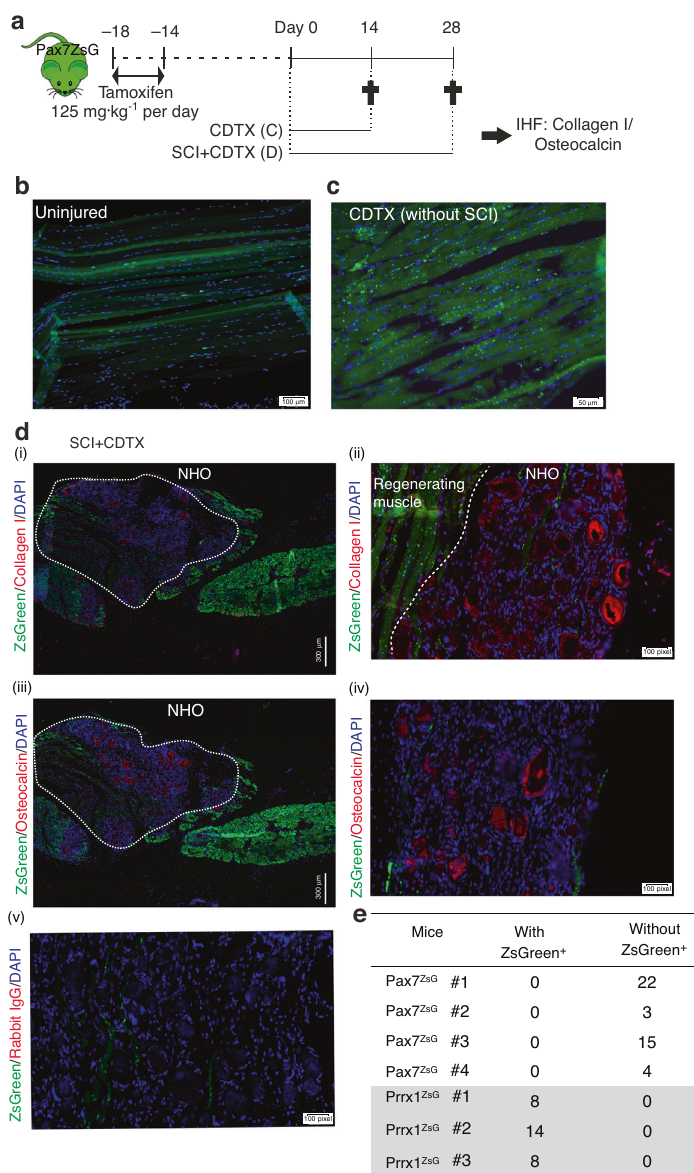
Fig. 2 NHOs are not derived from Pax7 expressing SCs. a ZsGreen expression in Pax7 ZsG mice was induced by tamoxifen treatment for 4 days. Two weeks after tamoxifen treatment, the mice received an intramuscular injection of CDTX with or without SCI. Muscle samples were harvested 14 or 28 days post-injury. Representative IHF images illustrating the distribution of ZsGreen + SC-derived cells in ( b ) uninjured muscle and ( c ) regenerated injured muscle 14 days post-CDTX injection in the Pax7 ZsG mice without SCI ( n = 3 mice/group). Scales bars: ( b ) 100 μ m, ( c ) 50 μ m. d Representative images from the Pax7 ZsG mice with SCI and CDTX-mediated muscle injury 28 days post-surgery. i IHF staining illustrating that ZsGreen + cells are present among areas of regenerating muscle and largely absent from areas of NHO development. White dashed lines indicate the boundary between regenerating muscle and fi brotic area containing NHOs stained red (i – ii) for collagen I and (iii-iv) osteocalcin. Nuclei were stained by DAPI staining (blue). A negative control was performed using rabbit isotype IgG (iv). Scale bars: ( d ) ( i, iii ) 300 μ m, ( ii, iv, v ) 50 μ m. e Number of osteocalcin + NHOs intercalated with ZsGreen + cells or without ZsGreen + cells in both Pax7 ZsG ( n = 4 mice, total 44 osteocalcin + NHOs counted) and Prrx 1 ZsG mice ( n = 3 mice, total 30 osteocalcin + NHO counted). Statistical differences